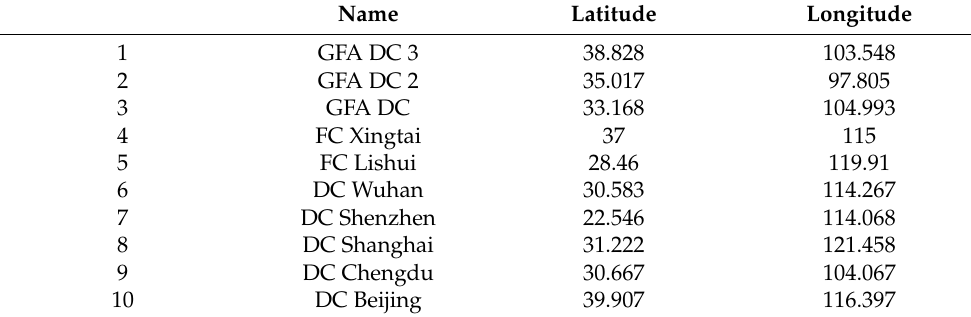
Table 5. GFA DC location.